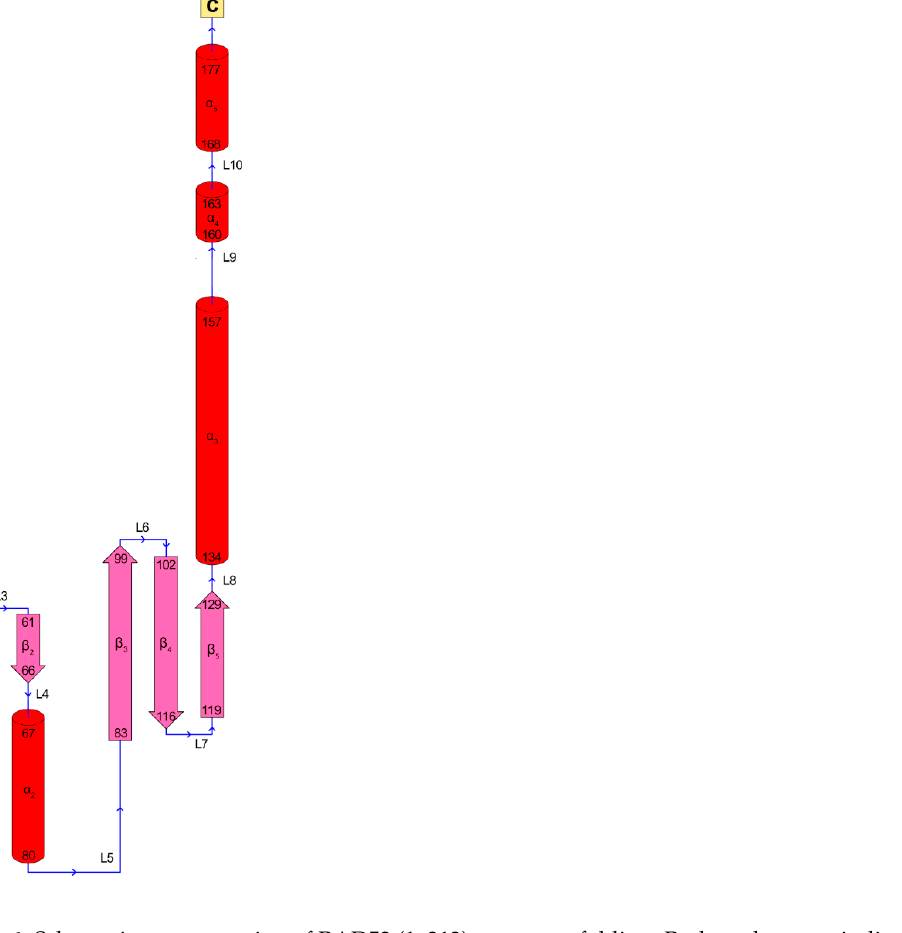
Figure 6. Schematic representation of RAD52 (1–212) monomer folding. Rods and arrows indicate helices and strands, respectively.